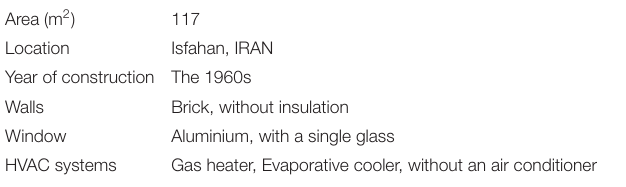
TABLE 2 | Characteristics of the investigated